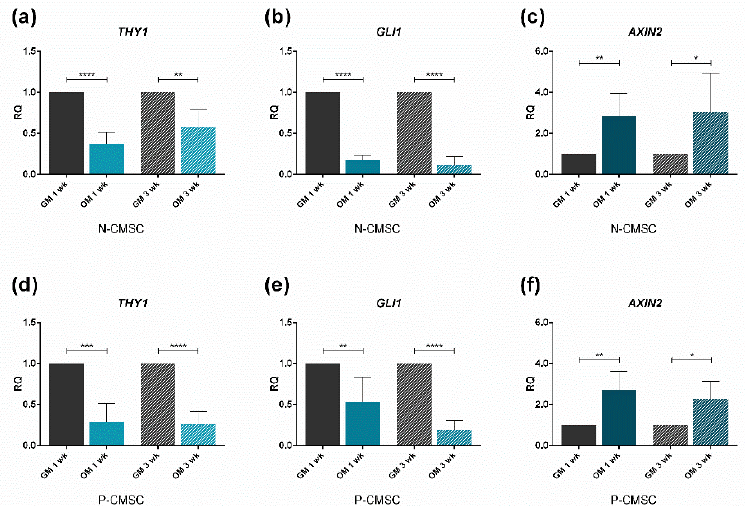
Figure 6. Expression profiles of putative niche marker genes. Transcript levels of: ( a , d ) THY1 ; ( b , e ) GLI1 ; and ( c , f ) AXIN2 , evaluated by qPCR in N-CMSC and P-CMSC, respectively, cultured with osteogenic medium (OM) for one (1 wk) and three weeks (3 wk). Cells cultured in standard growth medium (GM) were tested as controls at each time point. RQ, Relative Quantity (see Methods for details). * p < 0.05; ** p < 0.01; *** p < 0.001; **** p < 0.0001.